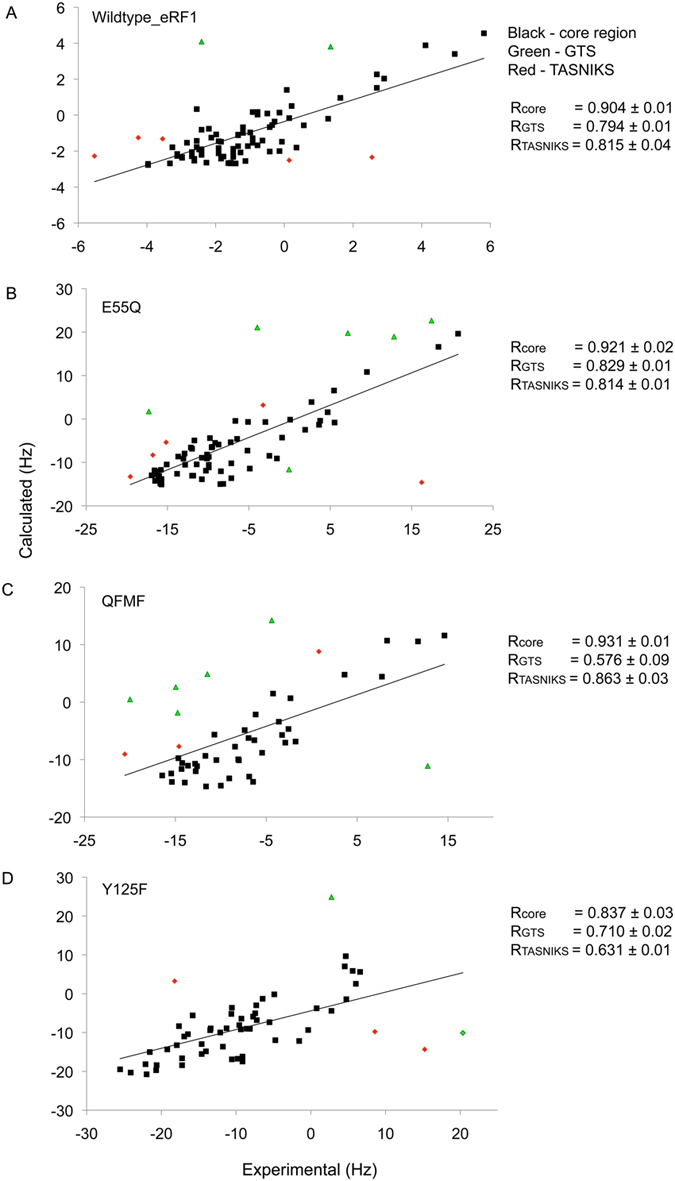
RDC experiments of wild-type and mutant eRF1 in C8E5 alignment media.Experimental and calculated residual dipolar coupling (RDC) for wild-type eRF1 and their correlation factors with respect to the full-length (A) wild-type eRF1 crystal structure without the GTS and NIKS regions, core (black), with the GTS loop included (green) and with the NIKS region included (red) using PALES. The same as observed for (B) E55Q and (C) Q122FM(Y)F126 (D) Y125F. The correlation coefficient for each protein is listed as RCORE, RGTS or RNIKS.